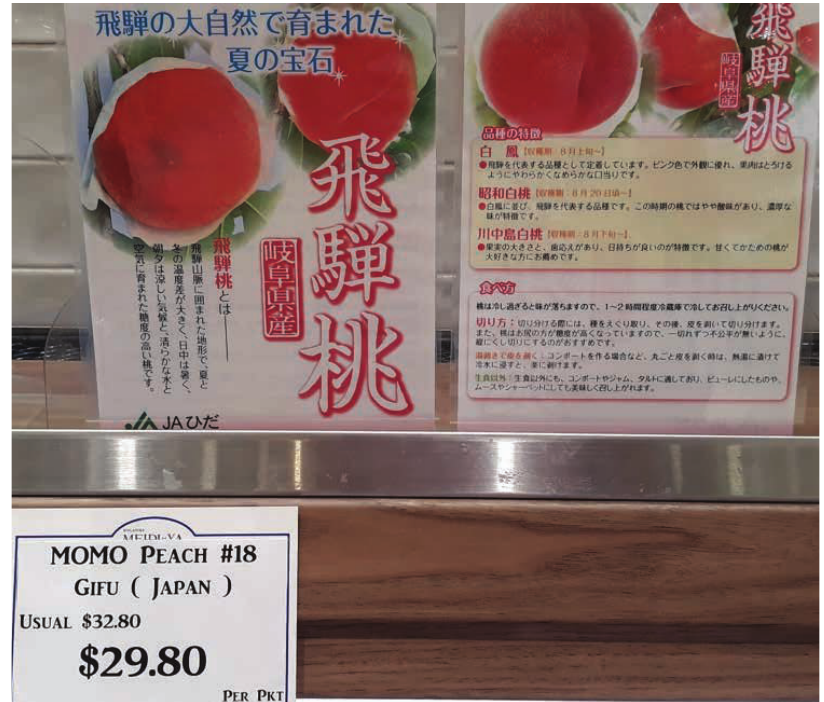
Figure 9.: “Summer’s jewels”: Peaches from